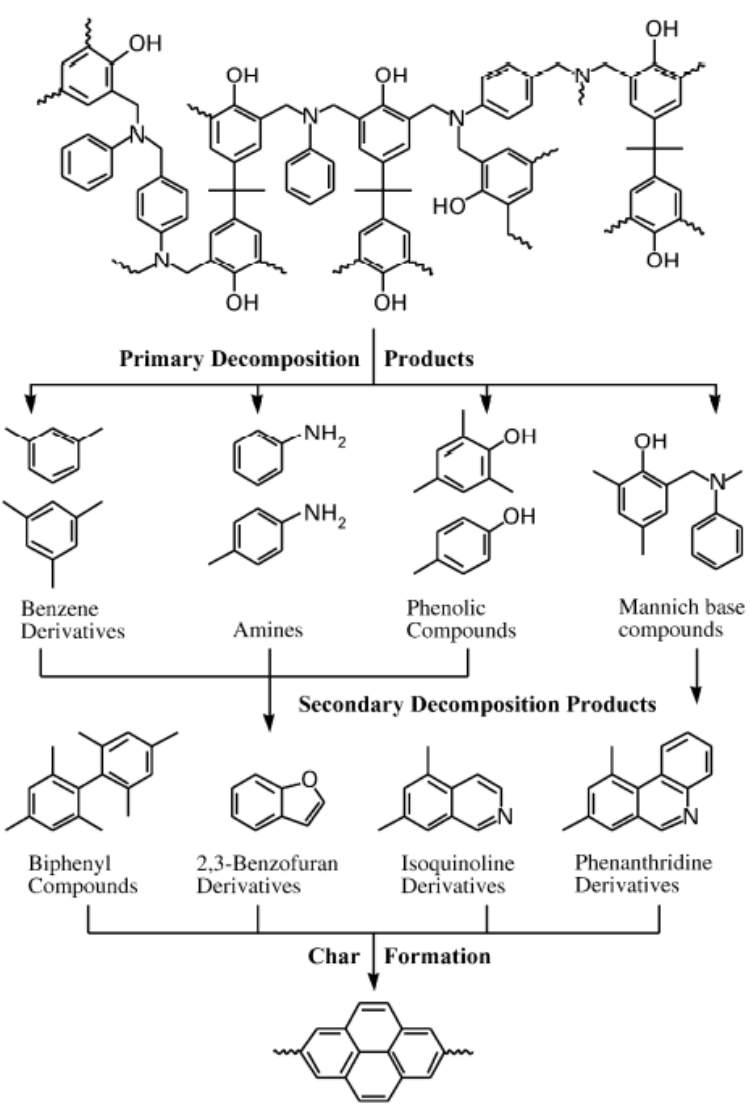
Figure 7. Deamination from C–N cleavage and deaminomethylation from C–C cleavage during char formation from BA-a. [46].